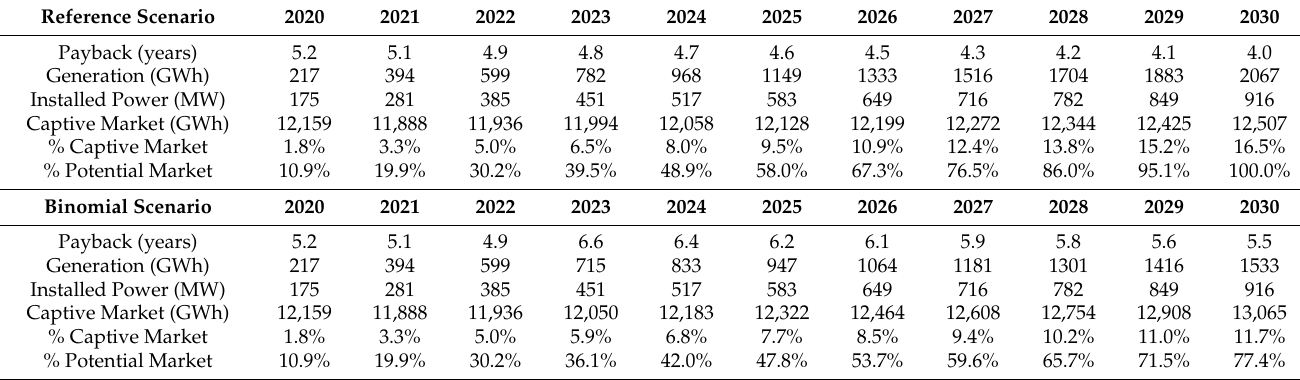
Table 7. MMDG expansion by Enel Cear á .